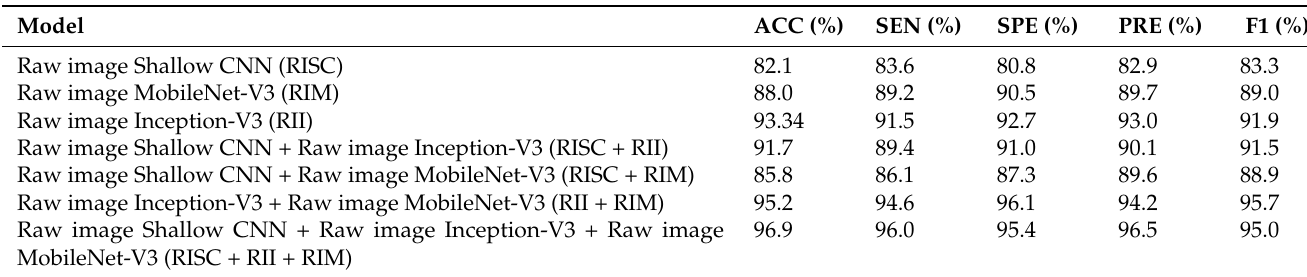
Table 11. Performance evaluation of the proposed model on the single and ensemble models using raw CXR image.